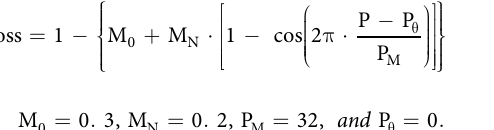
The parameters for Fig. 4(e,f): Erbium doped fiber (EDF): The EDF has a length of 10 m, g 0 = 2.38 dB/m, α = 0, β 2 = 10 ps 2 /km, β 3 = 0, γ = 5.0 (km − 1 W − 1 ), E sat = 50 (pJ). Single-mode fiber (SMF): The SMF has a length of 11 m, g 0 = 0, α = 0.17 dB/km, β 2 = − 23.6 ps 2 /km, β 3 = 0, γ = 1.387 (km − 1 W − 1 ), ν = 0 (km − 1 W − 3 ). The coupling ratio of the coupler is 40:60 (60% of the power is extracted from the cavity). The mode locker is modelled by a nonlinear loss function (periodic nonlinear loss for nonlinear polarization rotation based laser) 16, 42